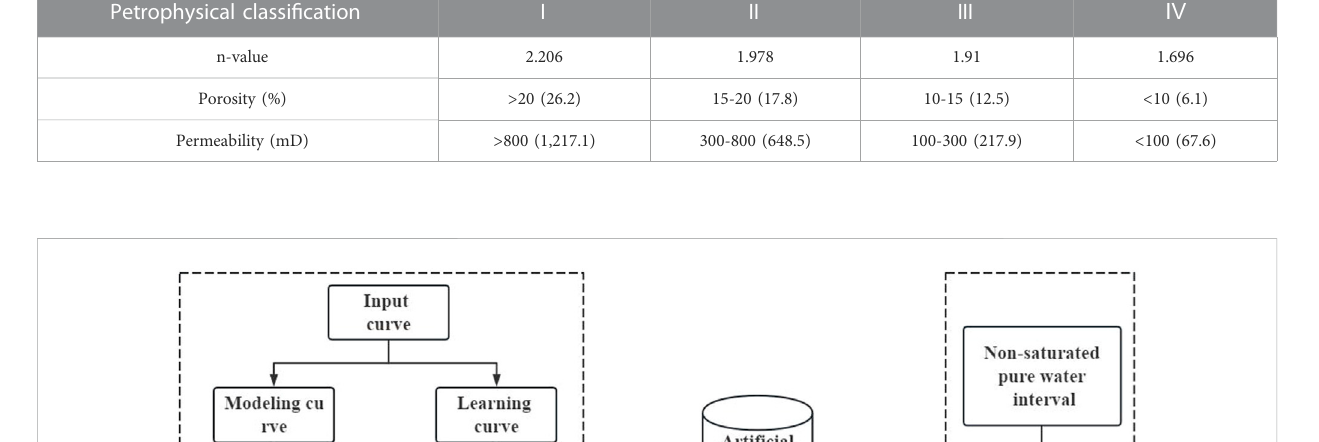
TABLE 1 ( Continued ) Criteria for the classi fi cation of petrophysical parameters of the reservoir in the target layer in the study area. Petrophysical classi fi